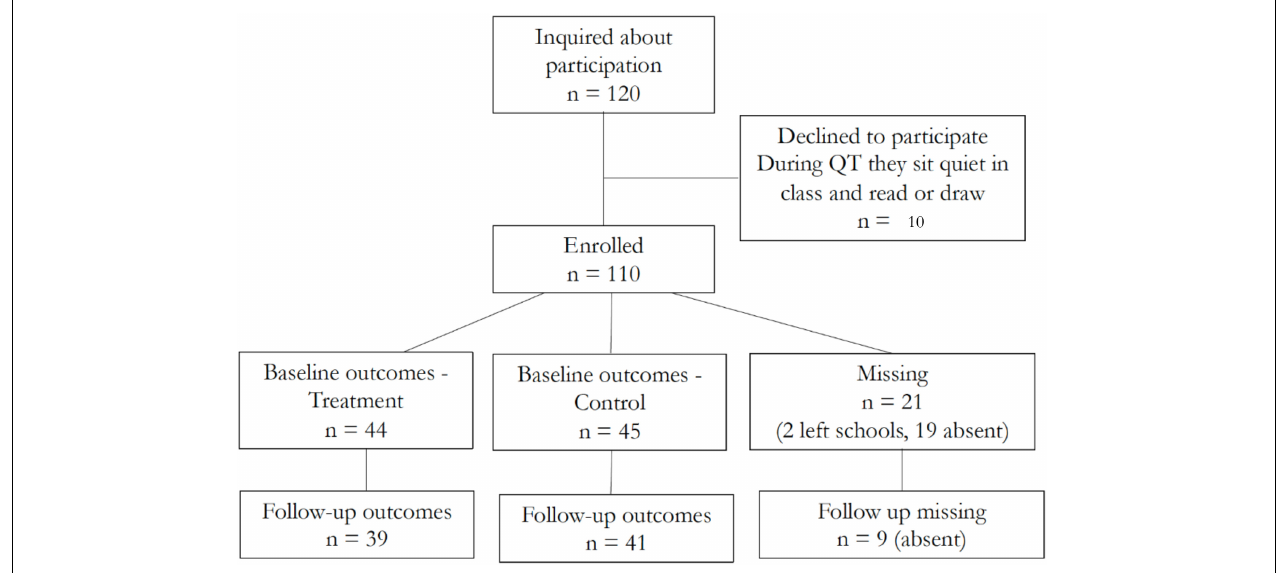
FIGURE 3 | CONSORT flow diagram – United Kingdom